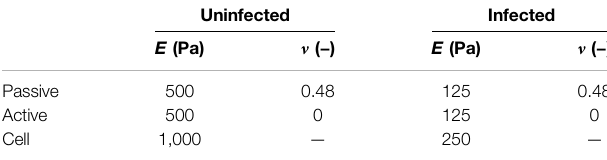
TABLE 2 | Mechanical parameters in our computational